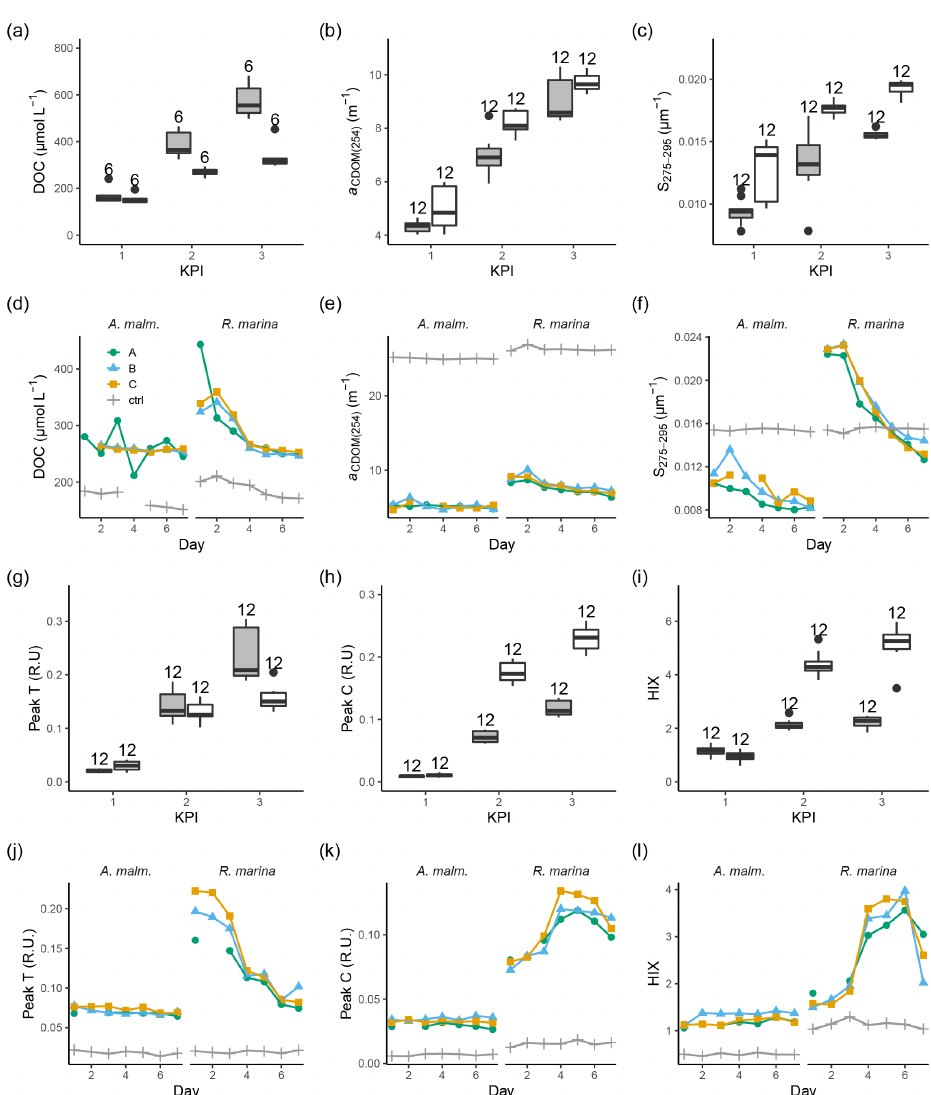
Figure 8. DOC concentration (a, d) , absorbance coefficient at 254nm (b, e) , spectral slope between 275 and 295nm (c, f) fluorescence peaks T (g, j) and C (h, k) , and humification index (i, l) at each KPI (0–12h measurements pooled) in the DOM release experiment (boxplots) and in the DOM consumption experiment (line graphs). Lines A, B, and C mark different replicates (culture filtrate + seawater bacteria), and ctrl marks the control (F/2 + seawater bacteria). The number above the boxplots shows the number of measurements. Lower and upper hinges of boxes mark the first and third quartiles, respectively, while the whiskers extend to the lowest and the highest value within 1.5 times the interquartile range. Grey boxes (left) show A. malmogiense , and white boxes (right) show R. marina . Optical variables not included in the detailed analysis are presented in Fig. A1 and Table A1 (DOM release experiment) and Fig. A2 (DOM consumption